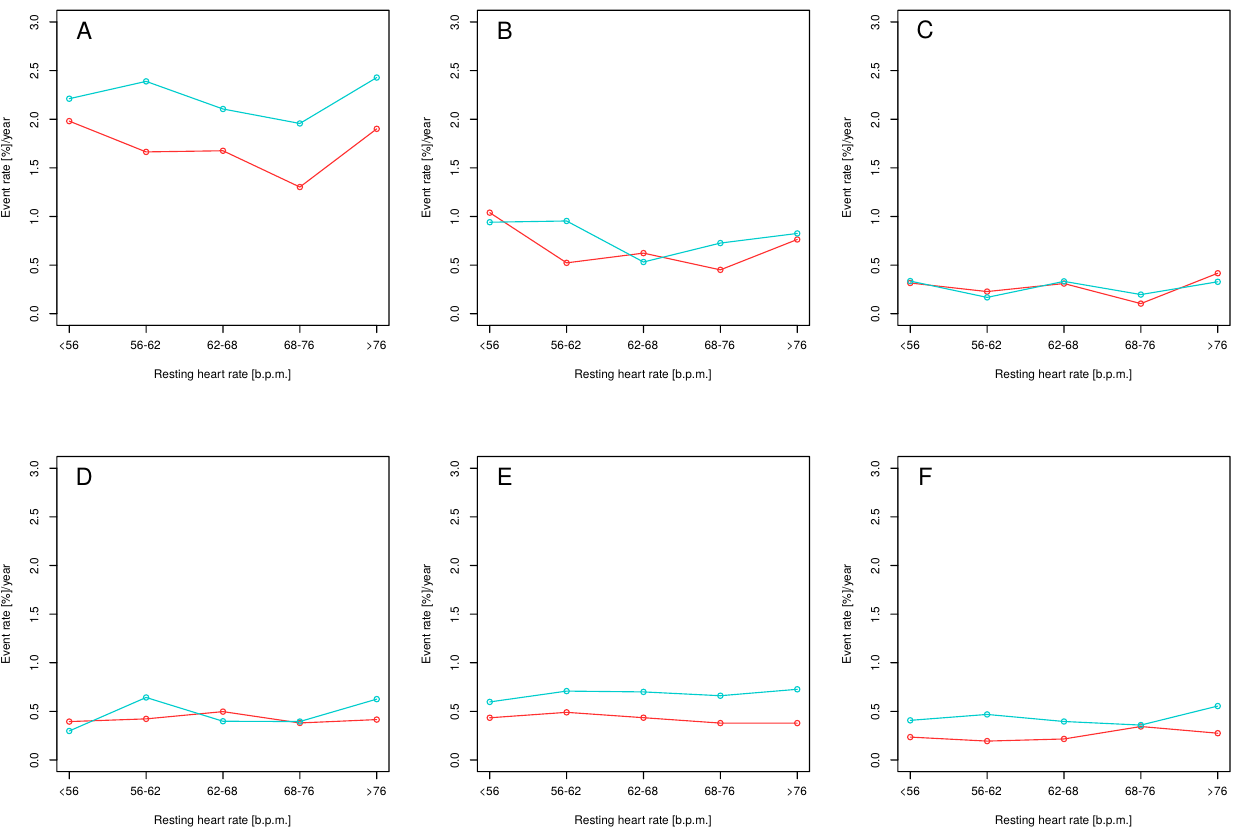
Figure 1. Yearly event rates for mean baseline resting heart rate in intensive (red) and standard (blue) treatment arms for the primary endpoint ( A ), myocardial infarction ( B ), acute coronary syndrome other than myocardial infarction ( C ), stroke ( D ), acute exacerbation of heart failure ( E ), and cardiovascular death ( F ). The primary outcomes were myocardial infarction, acute coronary syndrome other than myocardial infarction, stroke, acute exacerbation of heart failure, and cardiovascular